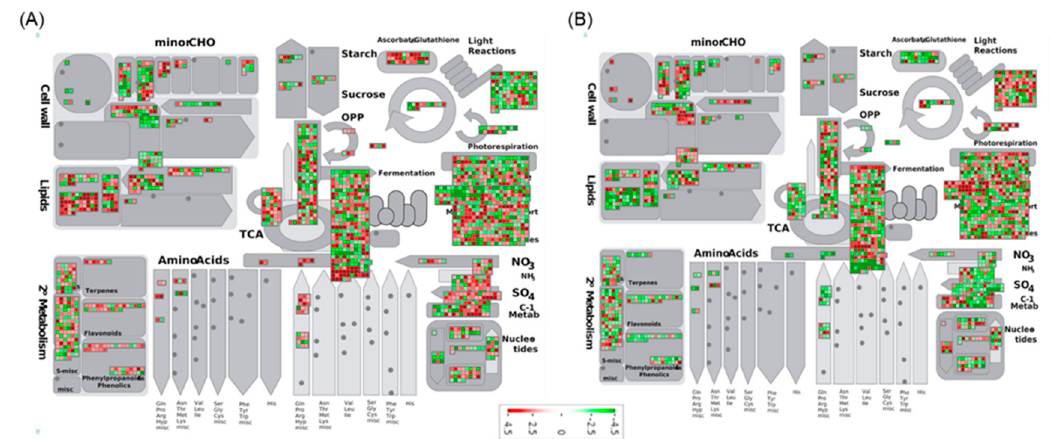
Figure 4. MapMan pathway analysis shows the differences in activity of different cellular metabolisms between the genotypes ( A ) PI 257145 and ( B ) PI 224448.